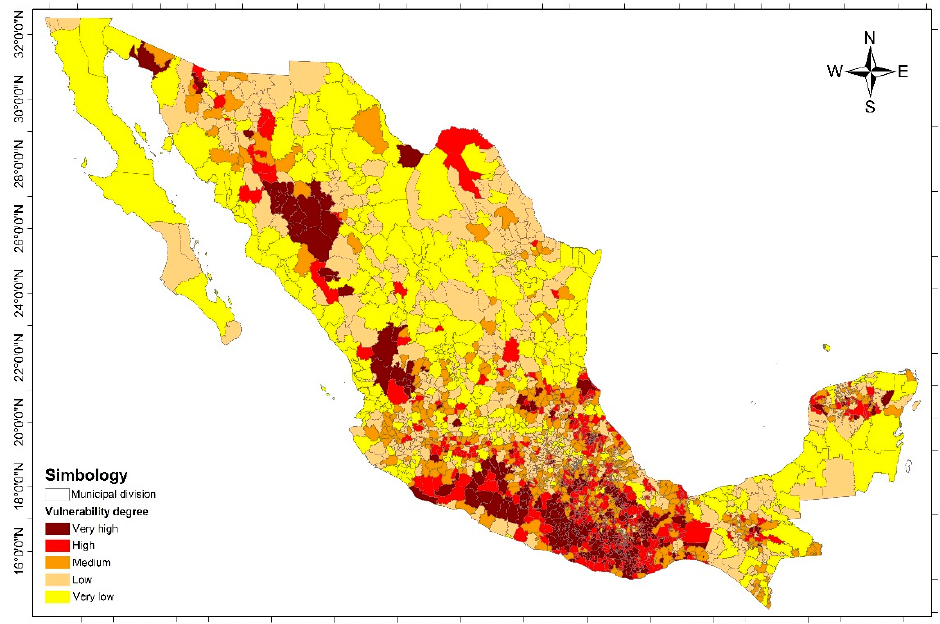
Figure 5. Map of social vulnerability to drought.